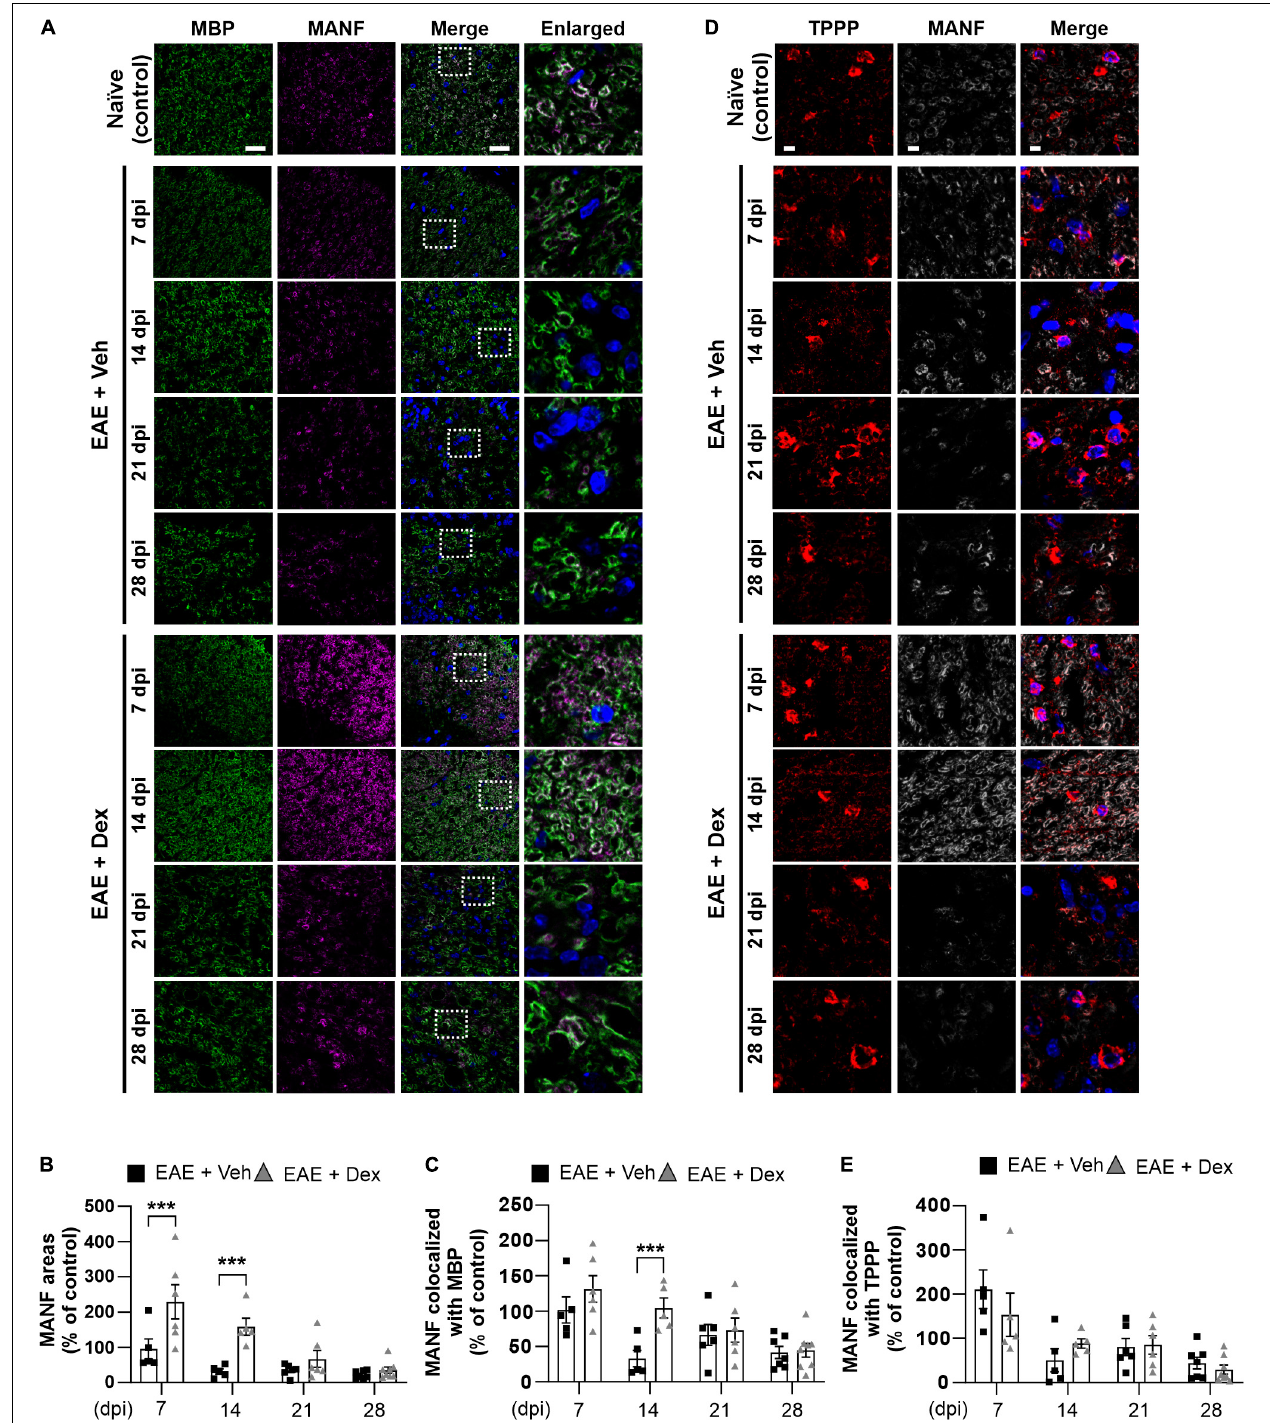
FIGURE 4 | MANF levels within myelin sheaths, but not the cell bodies of mature oligodendrocytes, were increased by dexamethasone in the early stage of EAE. (A) Representative fluorescence images of MBP (Green), MANF (Magenta), and DAPI (Blue) in the white matter of mouse spinal cords at 7, 14, 21, and 28 dpi. Enlarged images were taken from boxed areas within merged images. (B) Quantification of MANF area in each time point. *** P < 0.001, Mean ± SEM. n = 5–8 per each group. (C) Quantification of MANF-expression area within MBP-positive areas at each time point. *** P < 0.001, Mean ± SEM, n = 5–7 per each group. (D) Representative fluorescence images of TPPP (Red), MANF (Light gray), and DAPI (Blue) in the white matter of mouse spinal cords at 7, 14, 21, and 28 dpi. (E) Quantification of MANF-expression area within TPPP-positive areas at each time point. n = 5–8 per each group. (B,C,E) 2-way ANOVA followed by Sidak’s post hoc test for multiple comparisons. Scale bars: 200 µ m for MBP, MANF, and Merge; 10 µ m for enlarged imaged. Data from 4 repeated experiments.